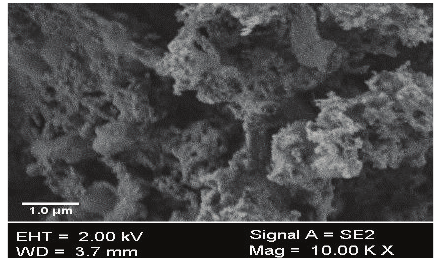
Figure 3: SEM analysis of C. polygonoides